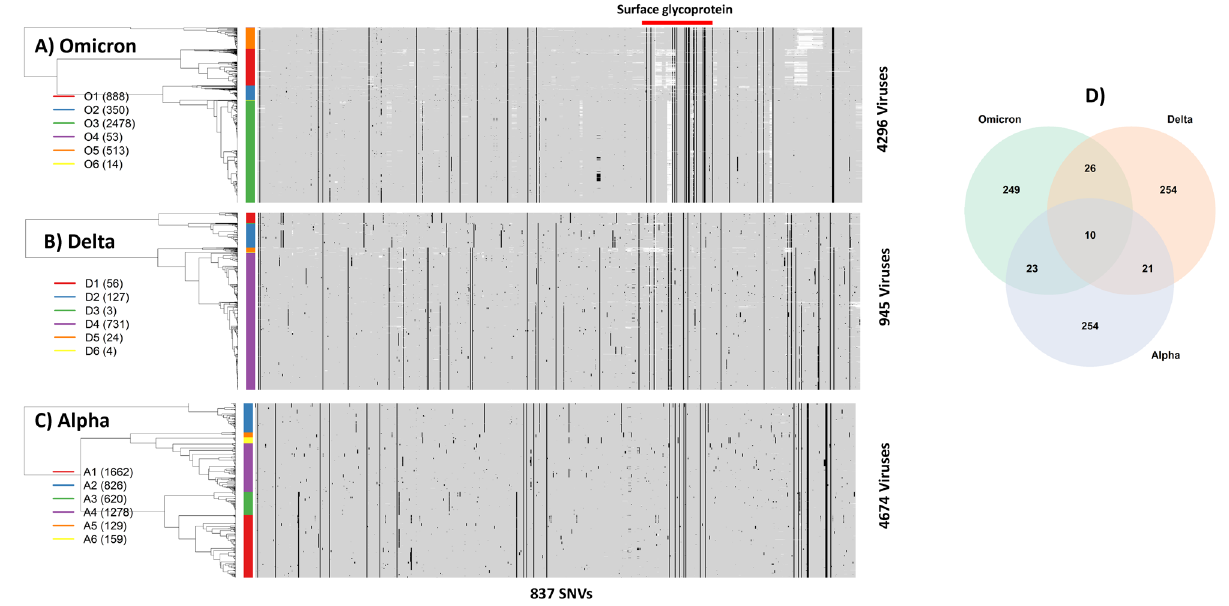
Figure 1. Mutation landscapes of ( A ) Omicron, ( B ) Delta and ( C ) Alpha variants from profiling presence or absence of single nucleotide variants (SNVs) genome wide. Each mutation is colored in a black spot, wild type gray, and missing nucleotide white spot. The tree structure (on the left side of each heatmap) represents the similarities/dissimilarities among viruses. Colored bars correspond to clusters of viruses, which are labeled on the left side along with the number of viruses (in bracket). The surface glycoprotein (“Spike protein”) is highlighted by a red bar on top of the heatmap. D) Venn-diagram resulted from the overlapping analysis of identified single nucleotide variants (SNVs) from the Omicron, Delta and Alpha. Heatmaps and Venn-diagram are generated by heatmap and Venn-diagram packages in statistical R software 3